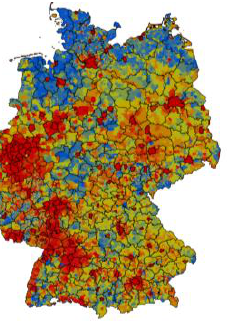
Figure 5. Result of the residual load analysis before grid dynamics are included at the municipality level. Blue indicates regions with a negative residual load, meaning that they have excess energy to lend. These regions are most heavily clustered in the north of Germany, where wind potential is greatest. Red indicates regions with a positive residual load.